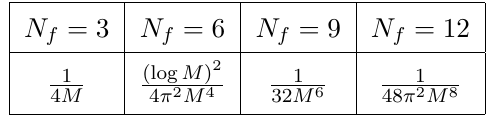
Table 3 . The leading part of ~ Z N f